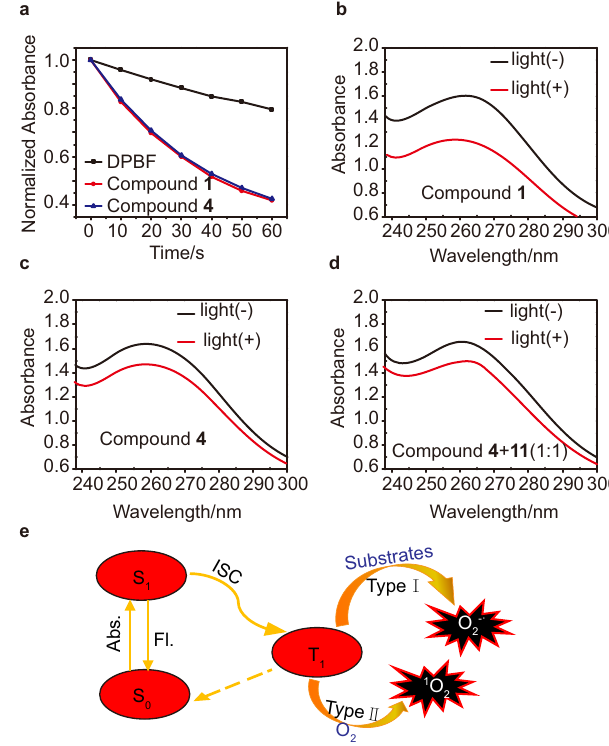
Fig. 3 ROS generation of compound 1. a Normalized absorbance of DPBF (50 μ M) at 411 nm in the presence of compound 1 (10 μ M) or 4 (10 μ M) as a function of irradiation time (white light: 20 mW/cm 2 ). b – d Degradation of NBT (24 μ M) by O 2 − • under different treatments ( “ + ” represents with irradiation, “ − ” represents without irradiation, white light 20 mW/cm 2 , 3 min). e Schematic illustration of O 2 − • and 1 O 2 generation. Abs. Absorb, Fl fl uorescence, ISC Intersystem Crossing, S 0 ground state, S 1 singlet state, T 1 triplet